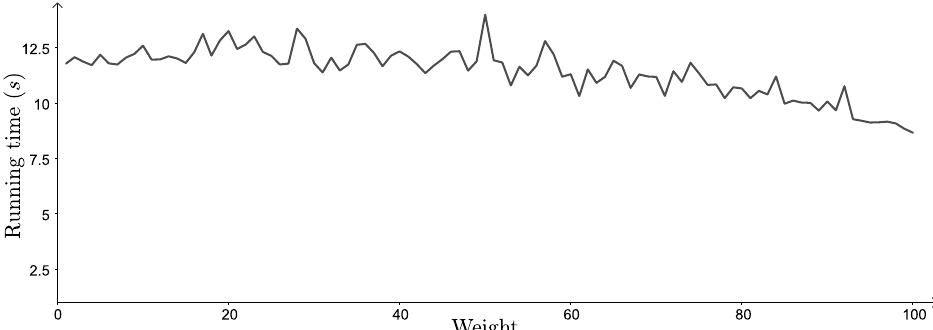
Figure 10. Running time (in seconds) required for computing the cardinality of the set V Q ( I PT ( L )) , for random partial Latin squares L ∈ L 10; m , with 1 ≤ m ≤